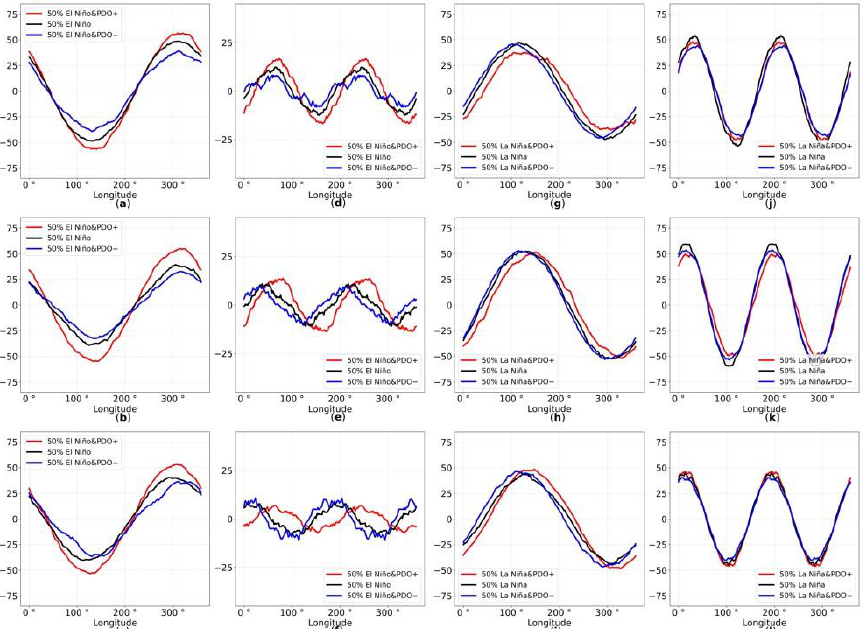
Figure 6. The 50th percentile of the phases and amplitudes of wave 1 in December ( a ), January ( b ), and February ( c ) and wave 2 in December ( d ), January ( e ), and February ( f ) along 60° N at 500 hPa in the EN experiment (black), EN&PDO+ (red), and EN&PDO − (blue) calculated over 99 model years. The 50th percentile of the phases and amplitudes of wave 1 in December ( g ), January ( h ), and February ( i ) and wave 2 in December ( j ), January ( k ), and February ( l ) along 60° N at 500 hPa in the experiments LN (black), LN&PDO+ (red), and LN&PDO − (blue) calculated over 99 model years.